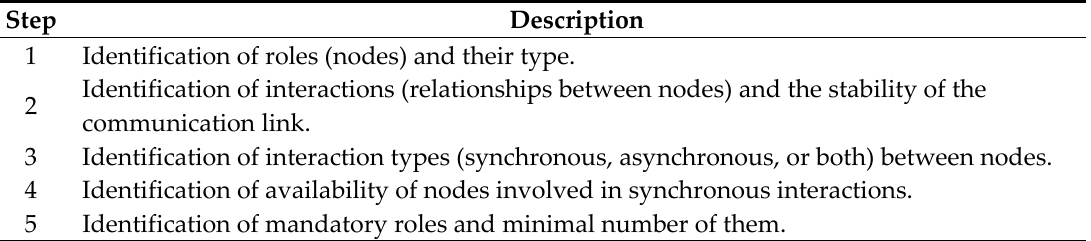
Table 6. Steps for CIMoN graph